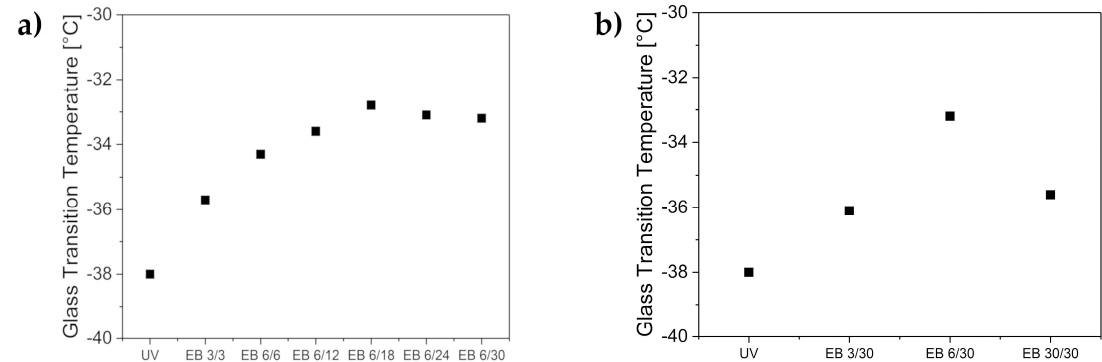
Figure 4. Glass transition temperatures of the UV-cured hydrogels compared to the hydrogels cured with electron beam, with the variation of ( a ) the total doses and ( b ) the differential doses. Additionally, IR spectra were recorded (Electronic Supplementary Information, Figure S1). All